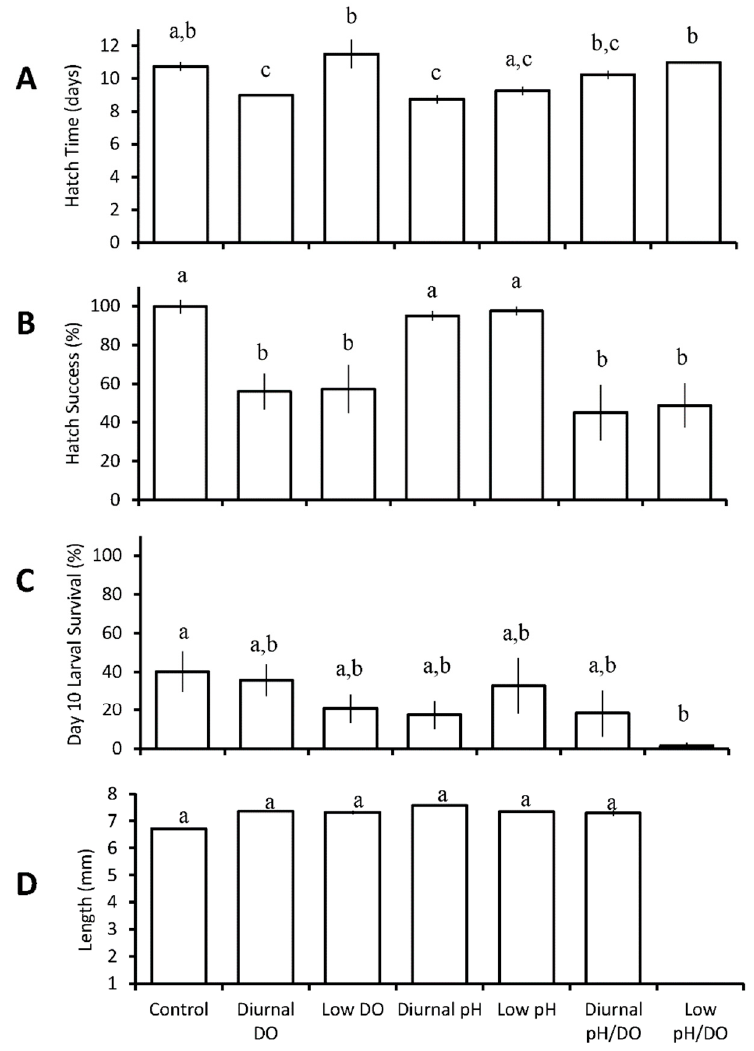
Figure 1. Hatch time ( A ), hatch success ( B ), survival ( C ), and length ( D ) of Menidia menidia larvae in the seven treatment diurnal acidification and hypoxia experiments (Table 2 and Tables S1–S4). Bars represent the mean (n = 4) for each treatment. Error bars represent standard error of the mean (n = 4). Letters on bars represent significant differences among groups as determined by Tukey Honest Significance Difference tests.